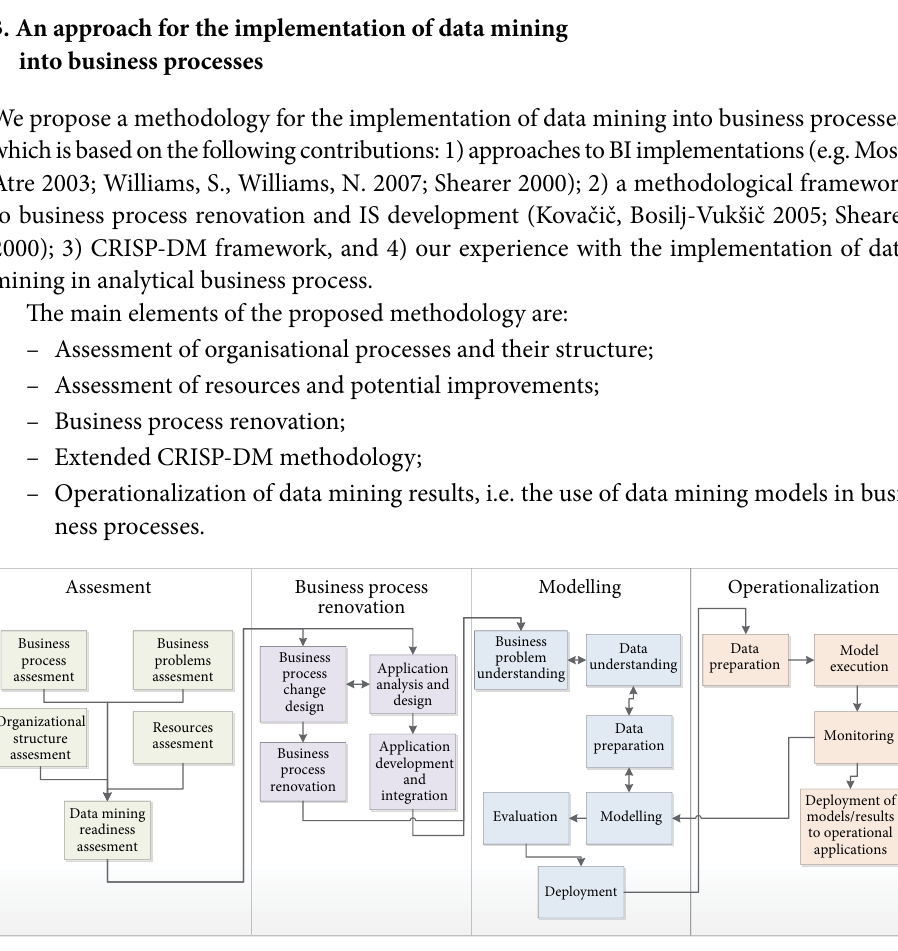
Fig. 1. The approach for successful implementation of data mining into business processes